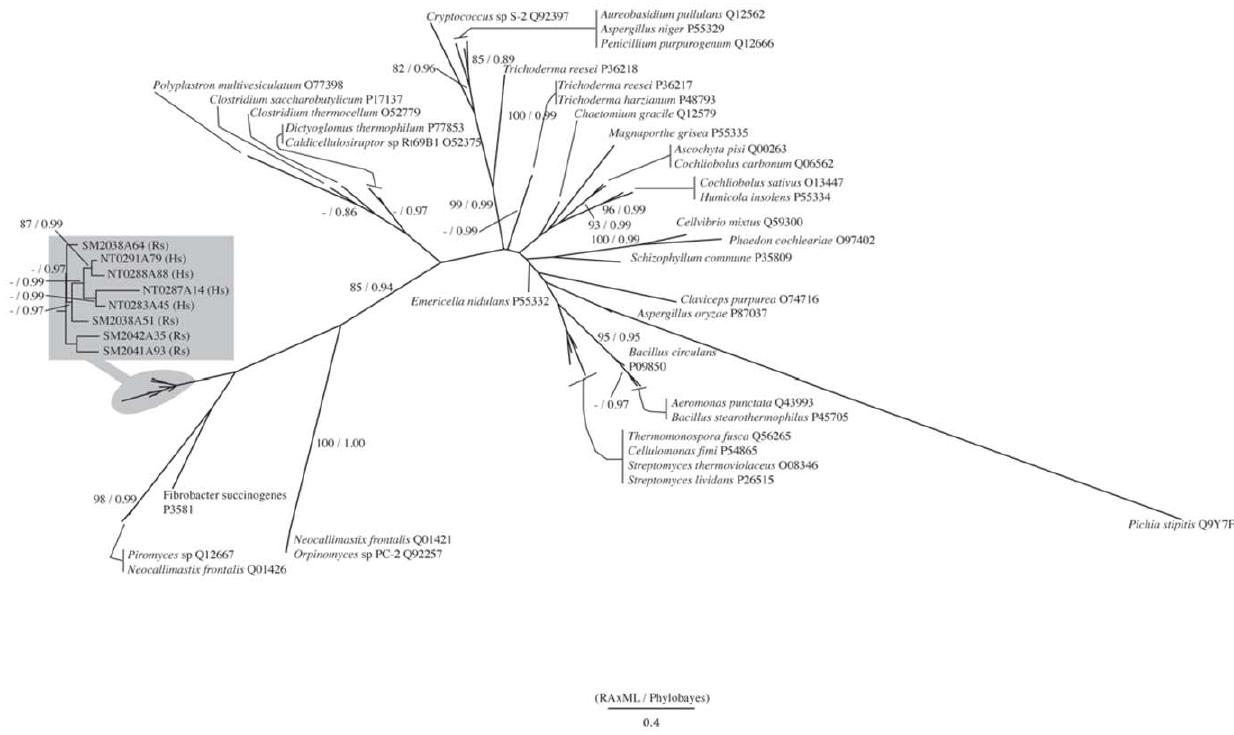
Figure 6. Phylogenetic tree of GHF11. Numbered clones (for example SM2038A64) are cellulase genes identified in this study from the symbiotic protists of termites. Letters in paretheses after each clone denote host termite species (Rs = Reticulitermes speratus , Nk = Neotermes koshunensis , Hs = Hodotermopsis sjostedti , Md = Mastotermes darwiniensis , Cp = Cryptocercus punctulatus ). Accession numbers of reference sequences are denoted after species names.